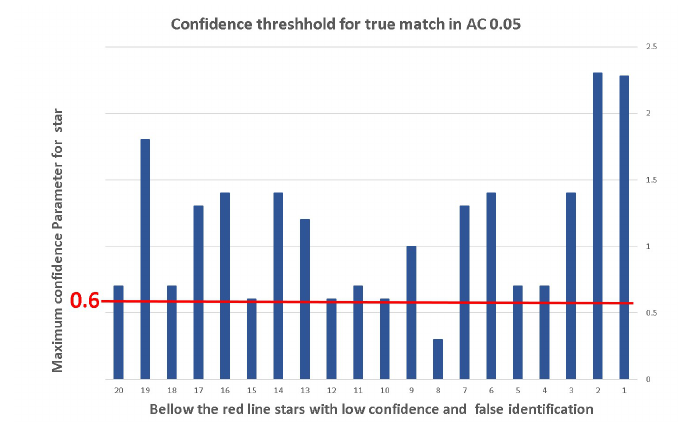
Figure 12. Confident thresh-hold for true match in AC 0.05.